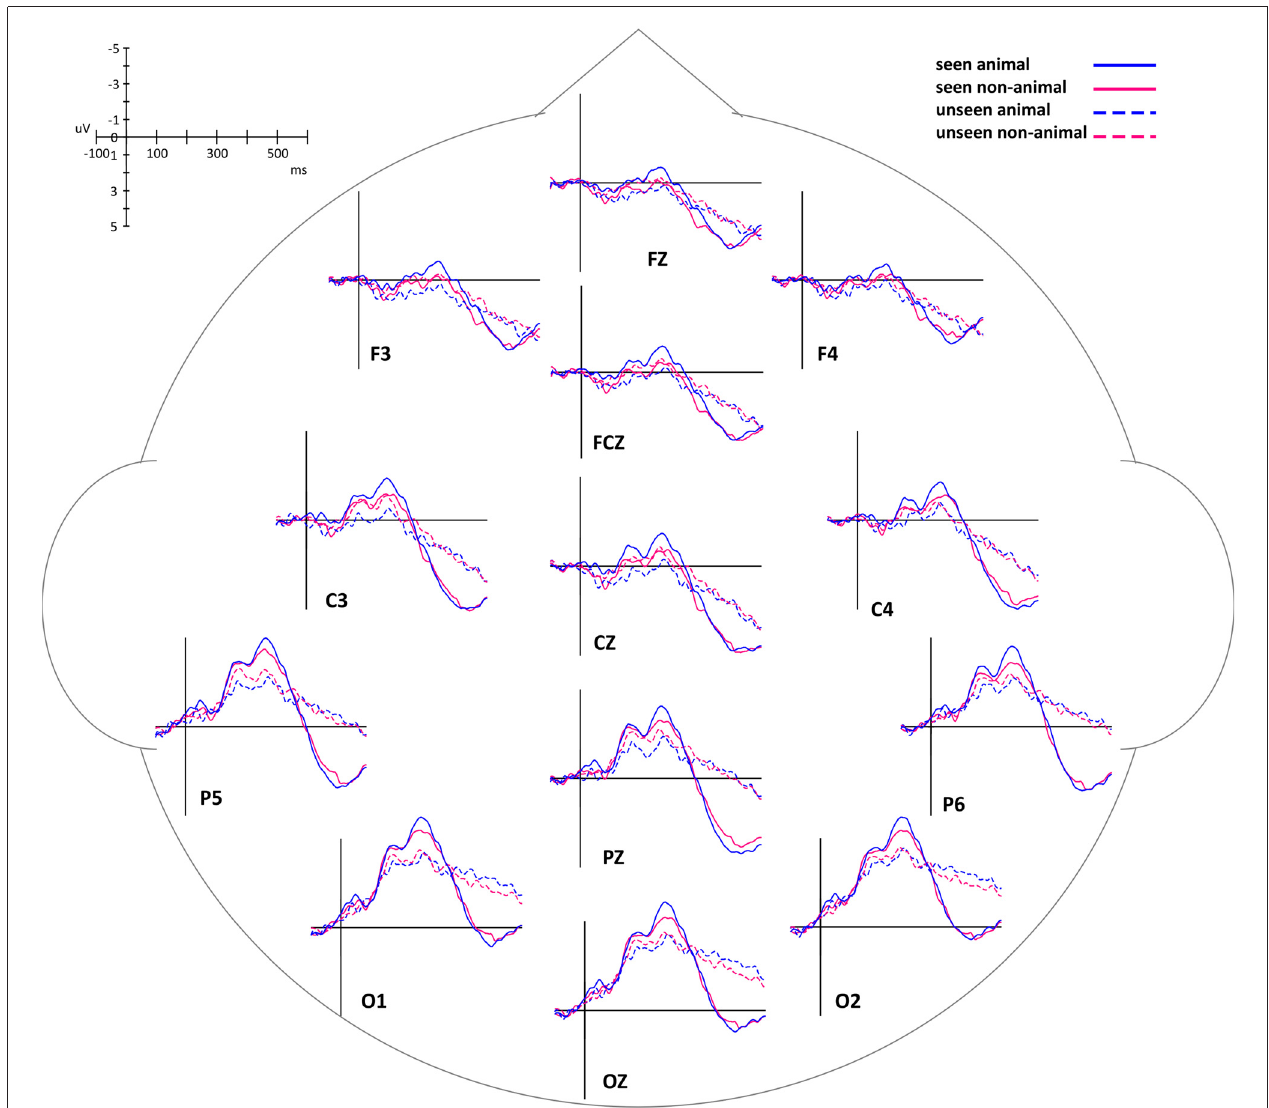
FIGURE 4 | Event-related potential (ERP) waveforms of animal and non-animal stimuli in seen and unseen trials, aligned to stimulus